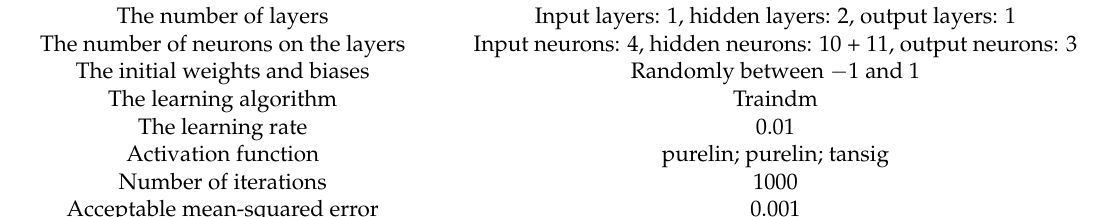
Table 3. The parameters of the proposed artificial neural network (ANN) model.